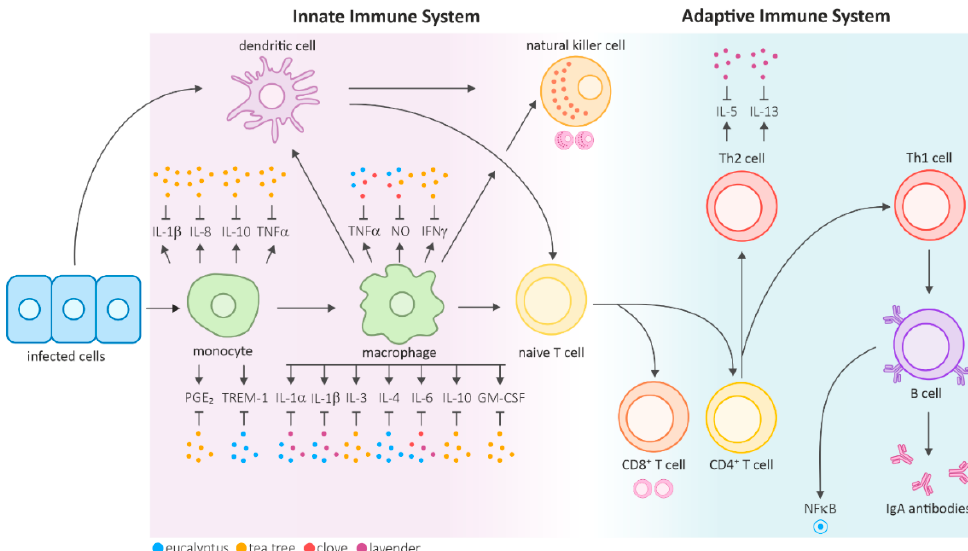
Figure 1. Overview of the mammalian innate and adaptive immune systems and the regulatory effects of selected essential oils on various cytokines shown as dots (adapted from [11]). Antigen-presenting cells (APCs), such as dendritic cells or macrophages, are recruited to the infection site. The released cytokines further activate natural killer cells and lead to the maturation of T cells. The reviewed studies identified multiple cytokines that were downregulated by eucalyptus, tea tree, clove, and lavender EOs. Specific interleukins and other factors are also expressed in other cell types. Most reviewed research articles focused on monocytes and activated macrophages. Hence, only those e ff ects are highlighted in the